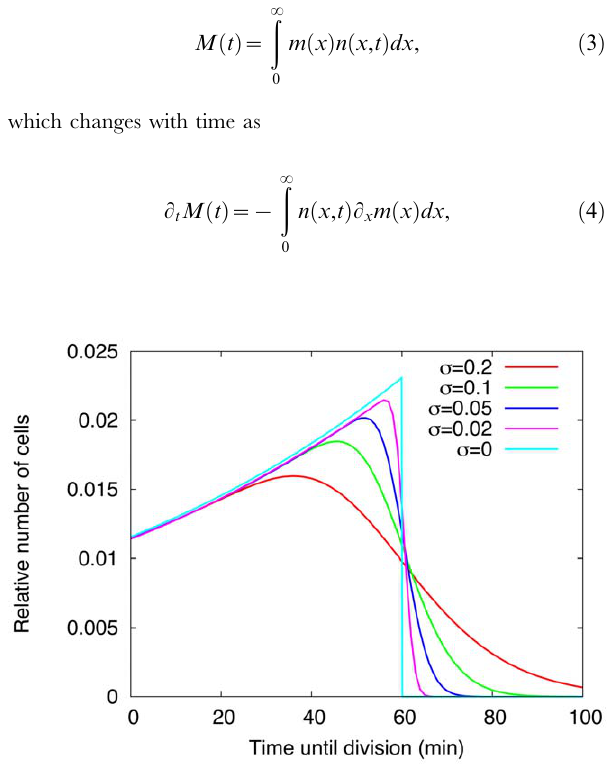
Figure 1. Steady state distributions of time until division for different noise levels. The steady state tud distributions n ( x , t ) = N ( t ) (where n ( x , t ) is the number of cells that have at time t a tud of x and N ( t ) is the total number of cells at time t ) were calculated from our model for different strength of divisional noise (quantified by the standard deviation s of birth masses of the daughter cells). Data shown are for s ~ 0 : 2 (red), s ~ 0 : 1 (green), s ~ 0 : 05 (blue), s ~ 0 : 02 (magenta) and s ~ 0 (cyan), where s is given in units of division mass. The prescribed doubling time is T D ~ 60min for all populations. For s ~ 0 (cyan line) the distribution scales as 2 x